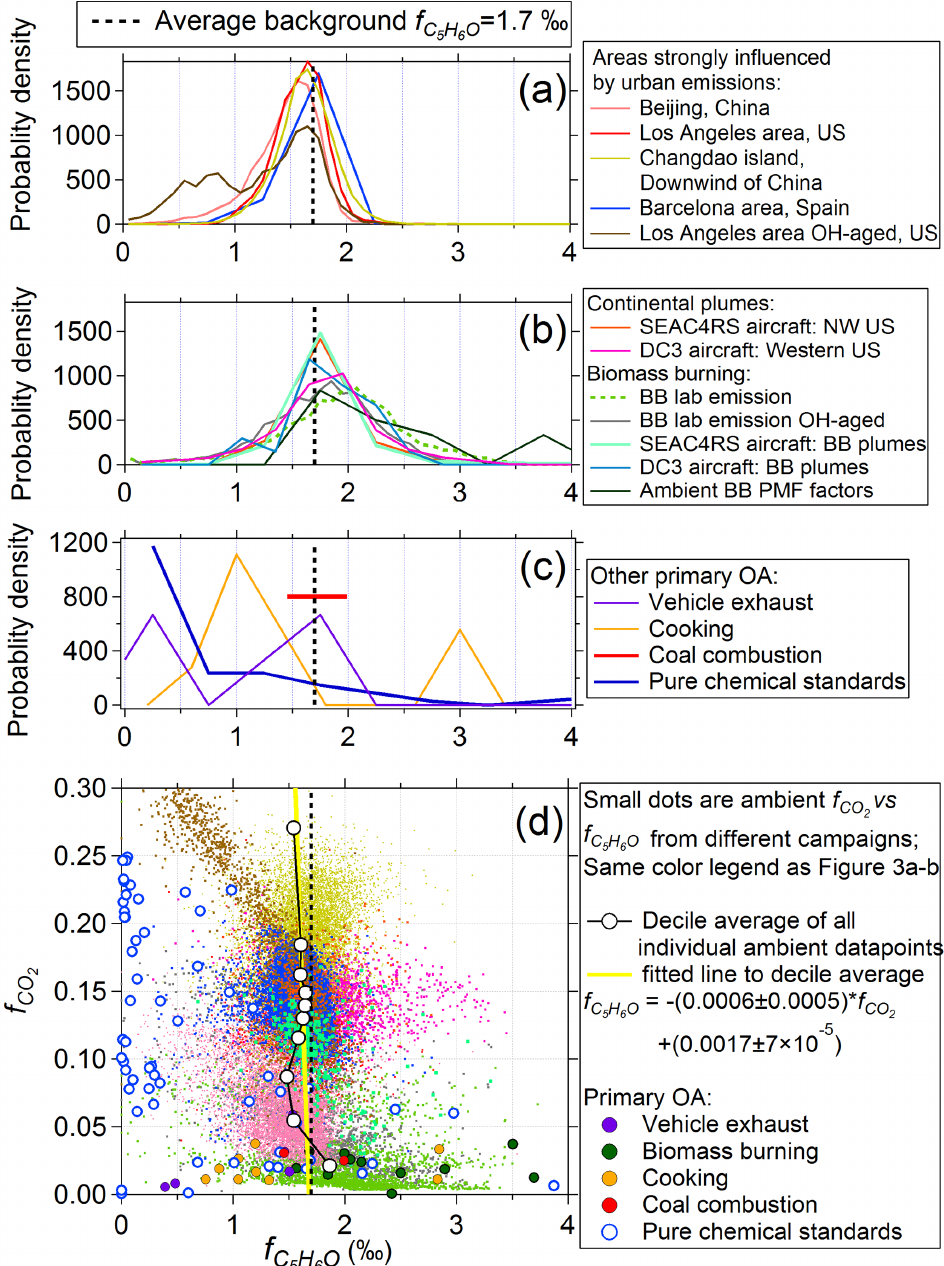
Figure 3. Probability density distributions of f C sampled from aircraft and biomass-burning emissions; (c) other anthropogenic primary OA sources and pure chemical standards. The dashed line (1.7‰) is the average f C shown in panels (a) – (c) , using the same color scheme. Quantile averages of f C linear regression line to the quantile